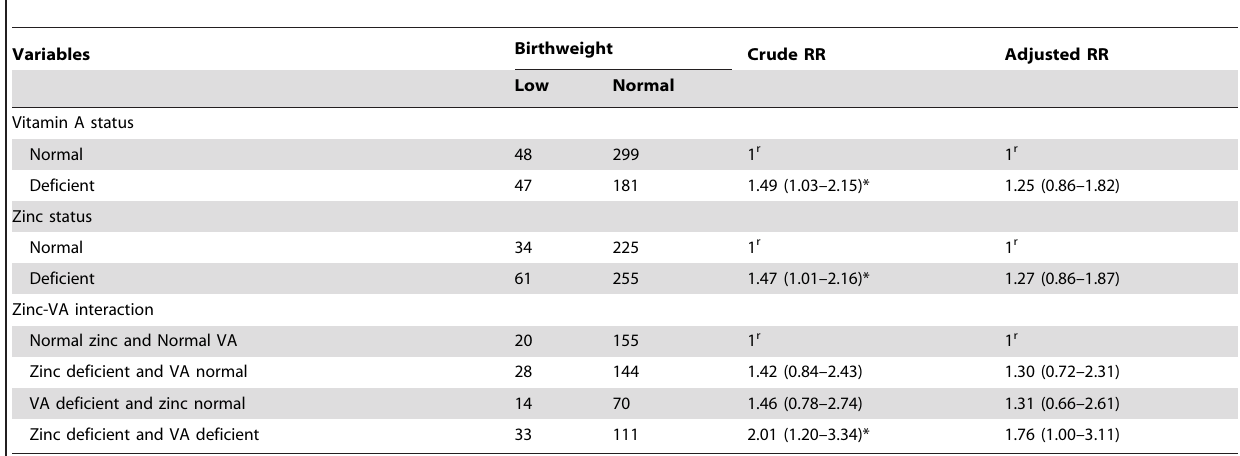
Table 3. Output of the log-binomial regression analysis on the association between LBW and Prenatal zinc and retinol statuses in rural Sidama, Southern Ethiopia, Jan–Oct 2011.